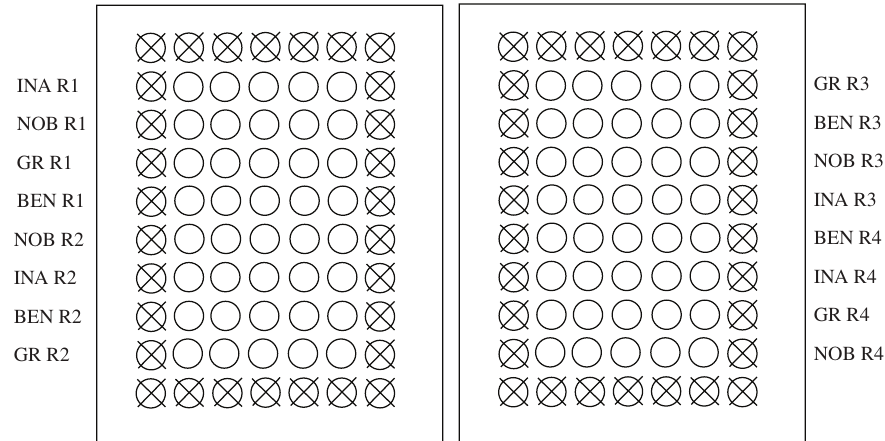
FIGURE 1: Graphical representation of the experimental design. Crossed drops were left out because of the border effect. R1–4 indicate the four replicates per cultivar.